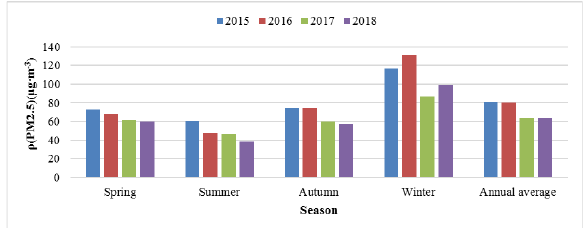
Variation Characteristics of PM2.5